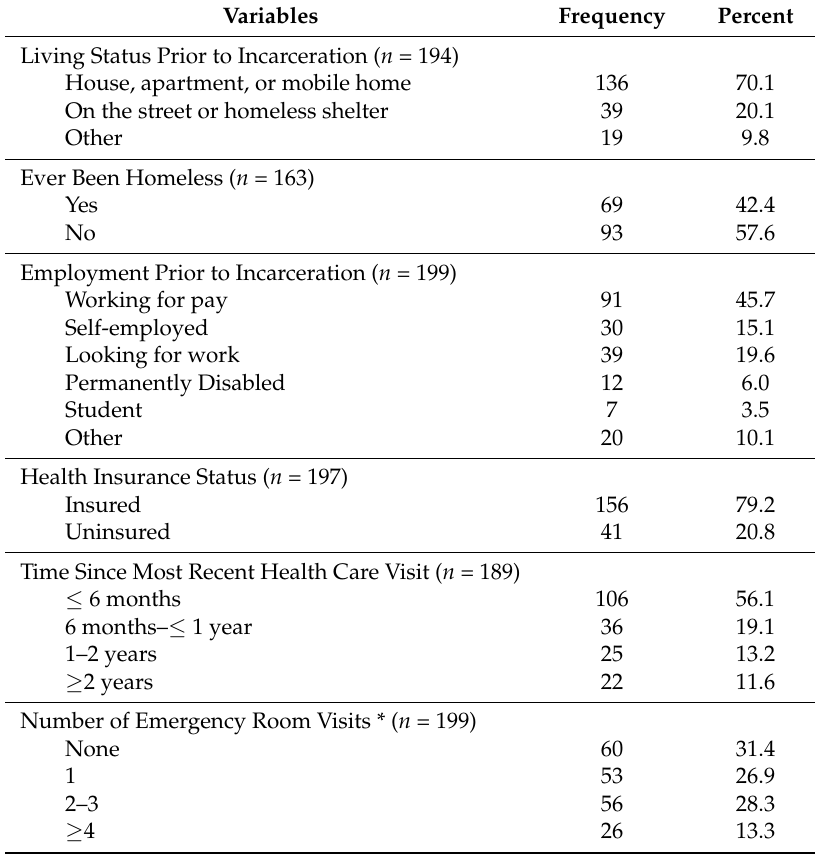
Table 2. Descriptive Statistics of Social